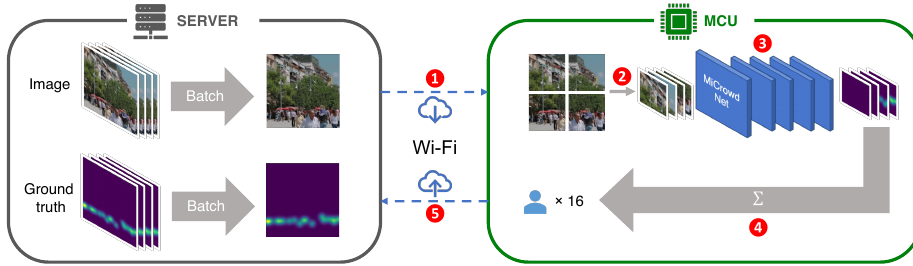
Figure 8. Our testbed to validate inferences on the resource-constrained MCU